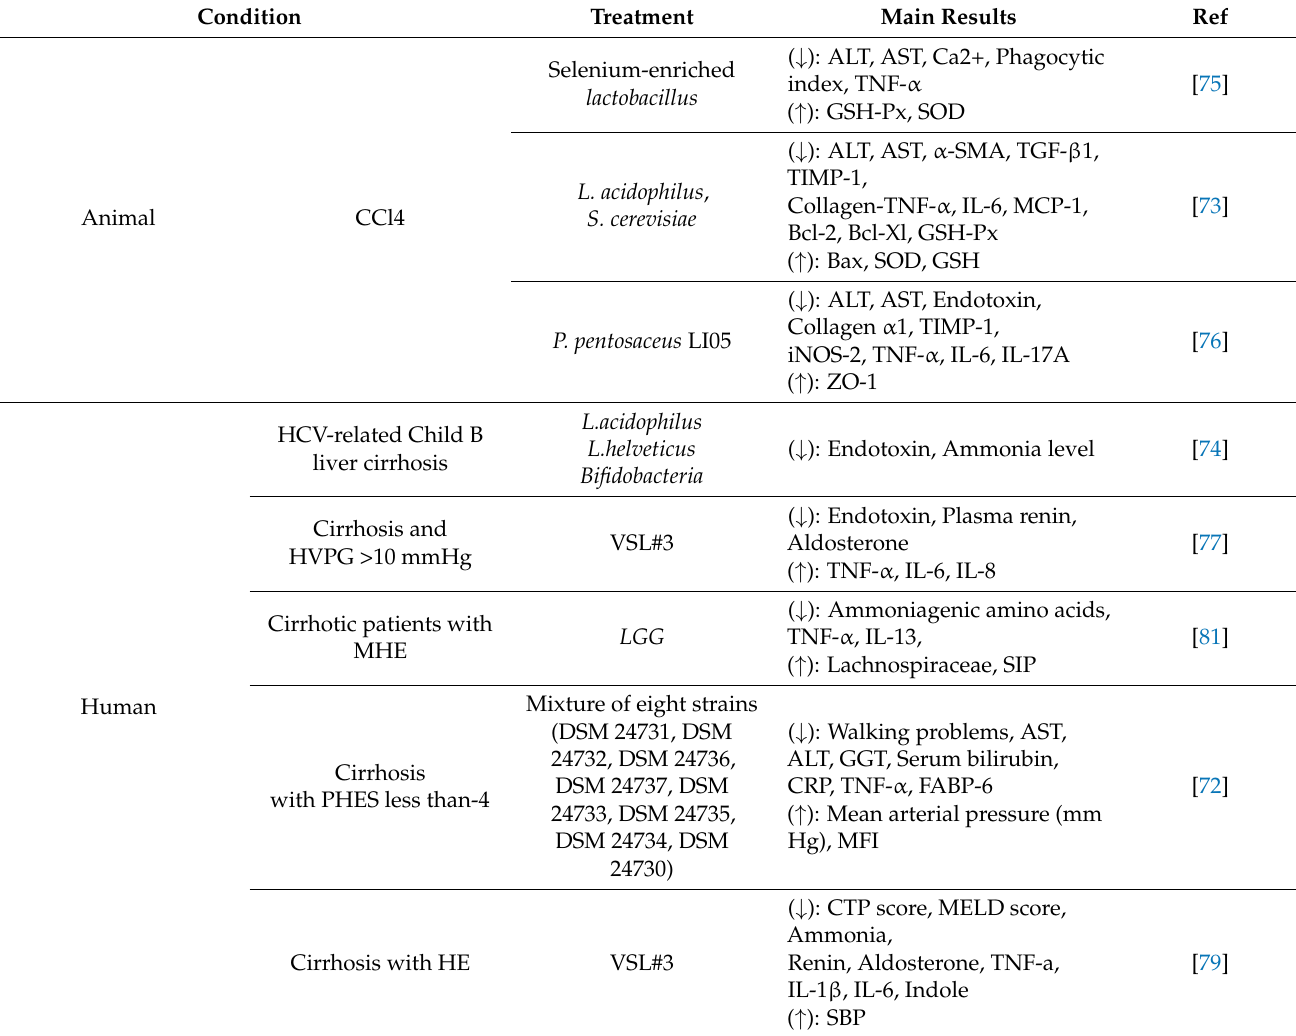
Table 3. Animal and human studies using diet in